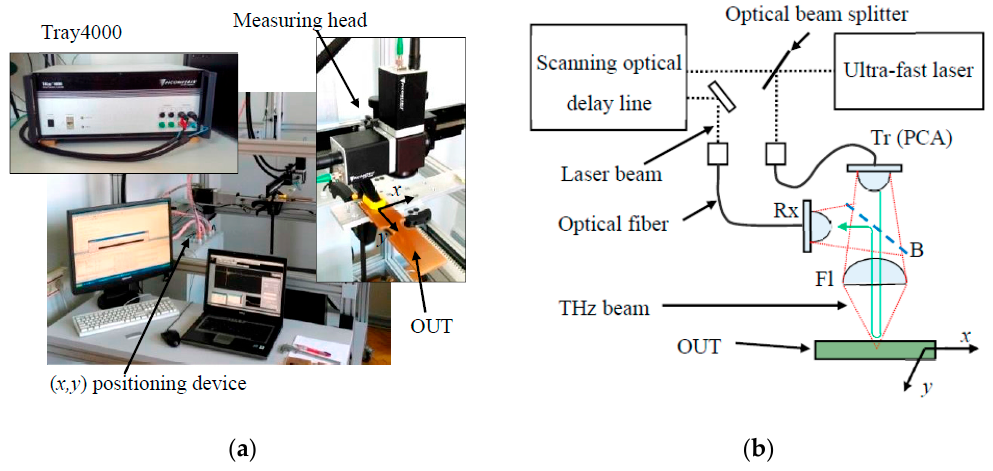
Figure 1. Utilized pulsed terahertz imaging system: ( a ) photo; and ( b ) simplified scheme; Tr—photoconductive transmitter, Rx—photoconductive receiver, OUT—object under test, Fl—focusing lens, B—beam splitter, PCA—photoconductive antenna.